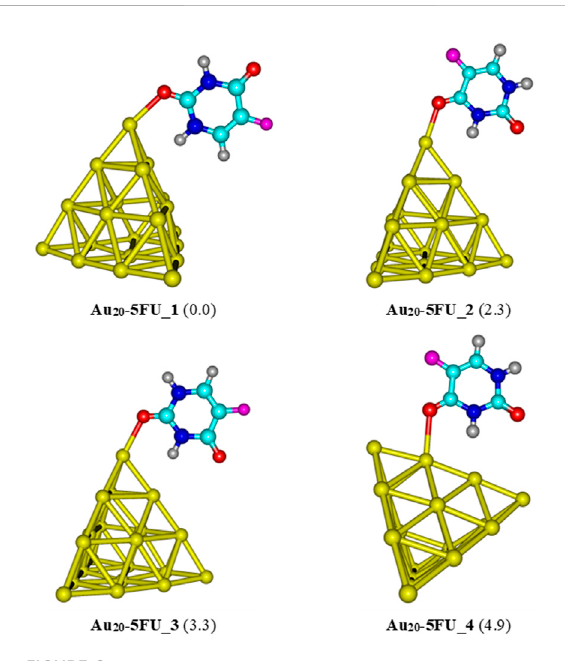
FIGURE 6 Low-lying structures of the Au 20 -5FU complex in the gas phase. Values indicated in parentheses are the relative energies (kcal/mol) with respect to the most stable structure Au 20 -5FU_1. Yellow, cyan, blue, white-gray, red, and magenta are used to represent the Au, C, N, H, O, and F atoms,